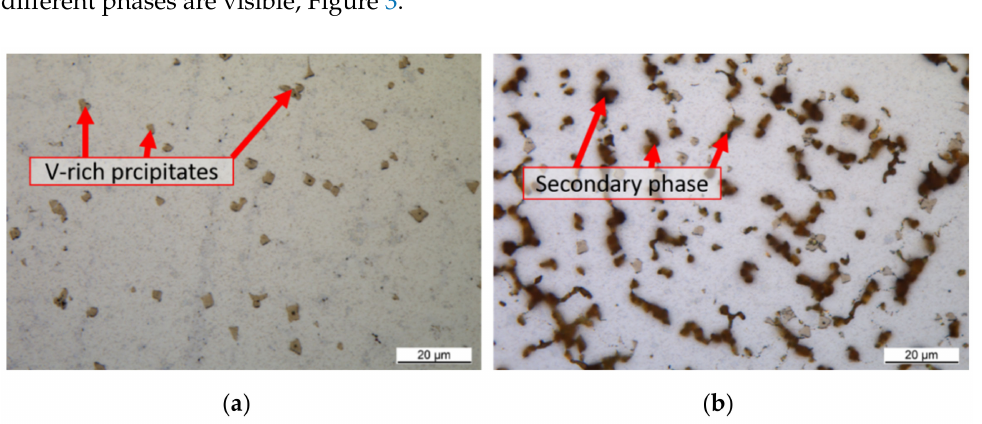
Figure 3. Microstructure of the as cast alloy ( a ) not etched, ( b ) Murakami